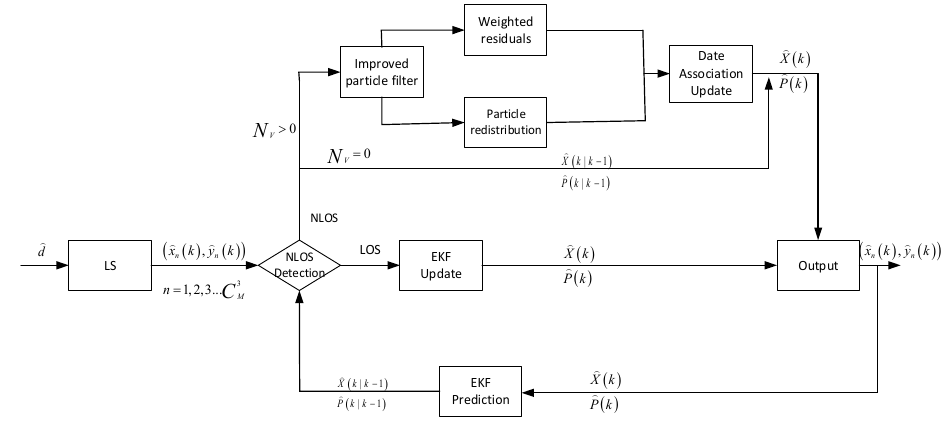
Figure 1. Flow chart of the proposed algorithm.